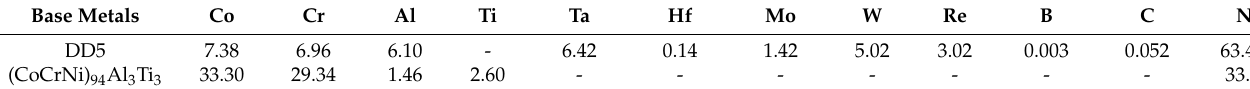
Table 1. Chemical composition of the DD5 single-crystal superalloy and (CrCoNi) 94 Al 3 Ti 3 MEA (wt.%).